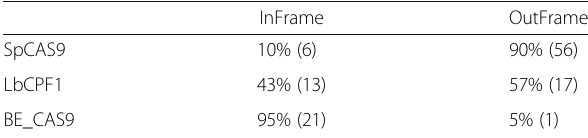
Table 2 Deletions out of frame (Out-frame), deletions that maintain reading frame (In-Frame) generated using SpCAS9, LbCPF1 and BE_nCAS9D10A expressed as % of total mutant alleles identified. A total of 60, 30 and 22 mutants alleles were identified for SpCAS9, LbCPF1 and BE_nCAS9D10A respectively (see also Fig. 3)